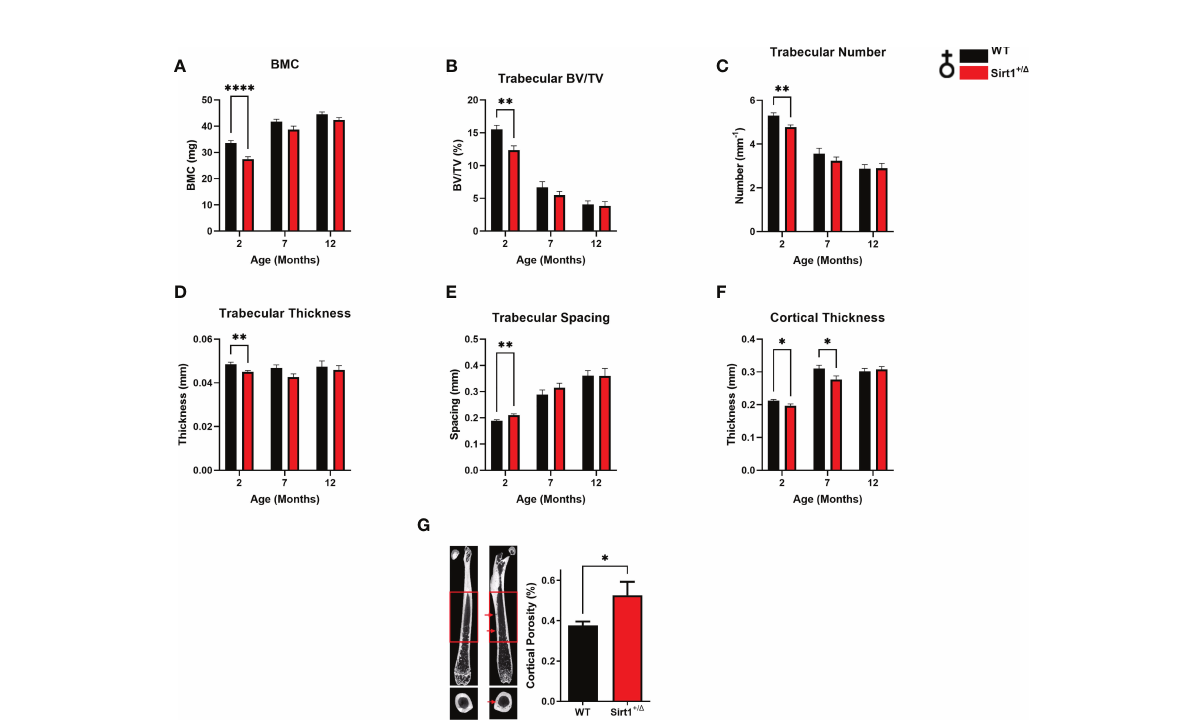
FIGURE 1 Sirt1 haploinsuf fi ciency leads to reduced peak cortical thickness, decreased trabecular bone volume fraction and increased cortical porosity in the femur in 129/Sv female mice. µCT analysis of femoral mid-shaft and distal metaphysis in 2,7,12-month-old Sirt1 +/ D and WT female mice. (A) Bone mineral content (BMC) (B) Bone volume fraction (BV/TV%) (C) Trabecular number (D) Trabecular thickness (E) Trabecular spacing (F) Cortical thickness (G) Cortical porosity percent in 7-month-old Sirt1 +/ D and WT female mice (n = 14-15 mice/group); representative image (left) and quanti fi cation (right); scale bar 1 mm. Results are Mean ± SEM analyzed by unpaired Student ’ s t test. * P < 0.05, ** P < 0.01, **** P < 0.0001 versus WT female mice. ((n = 7-11 mice/group). BV, bone volume; TV, total